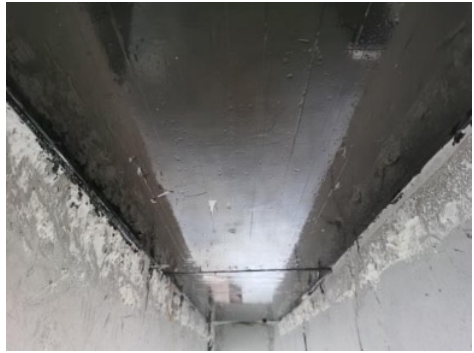
Figure 5. The plan of the polyurethane concrete reinforcement layer.